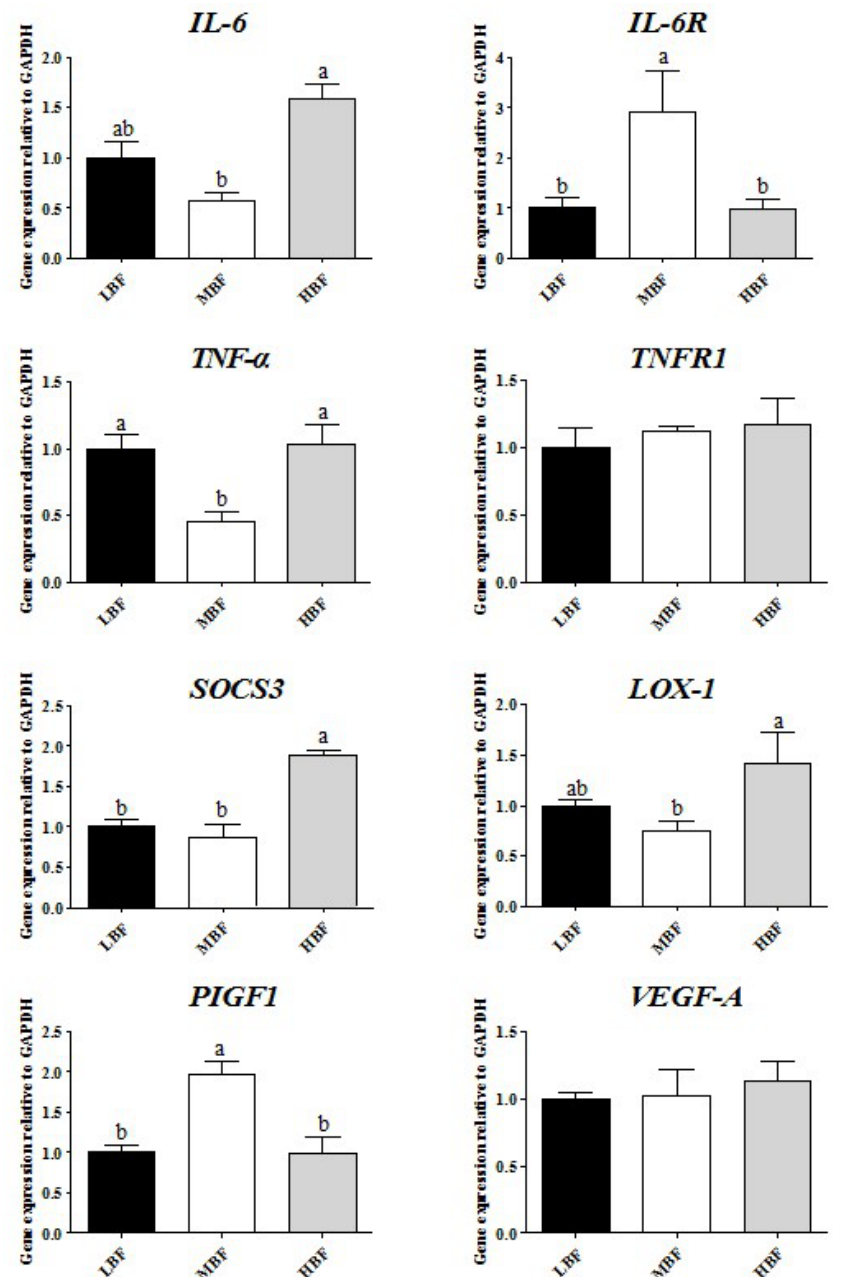
Figure 1. The mRNA levels of inflammatory genes in the placenta according to backfat thickness. Values are mean ± S.E.M. A difference in letter between columns is significant at p < 0.05.